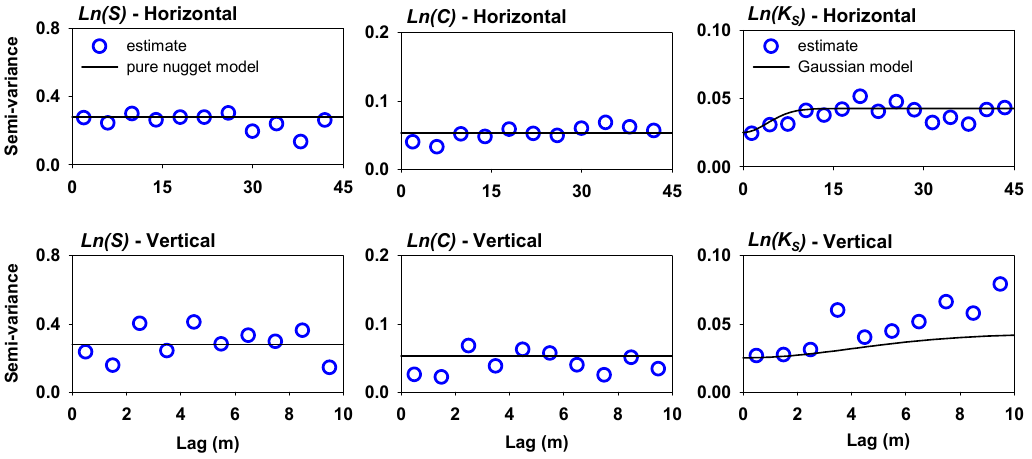
Figure 6. Theoretical semi-variogram fits to classical horizontal and vertical semi-variogram estimates for Ln(S) , Ln(C) , and Ln( K S ) . The pure nugget model is fit to Ln(S) and Ln(C) experimental semi- variograms; the Gaussian model is fit to Ln( K S ) experimental